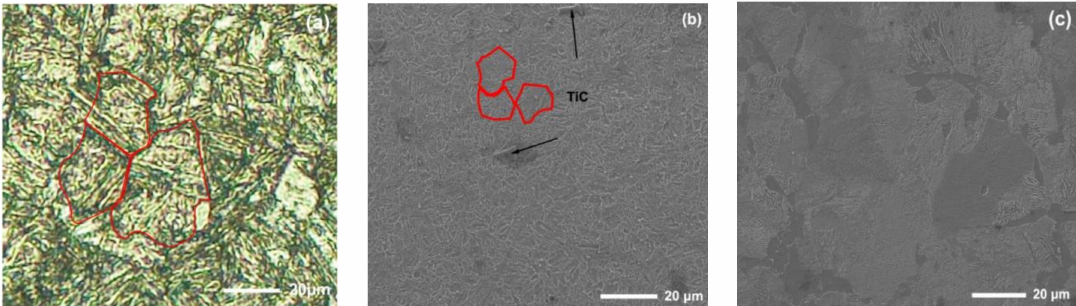
Figure 1. Microstructure of the test materials: ( a ) NM400; ( b ) ZM4-13; ( c ) 40Cr.